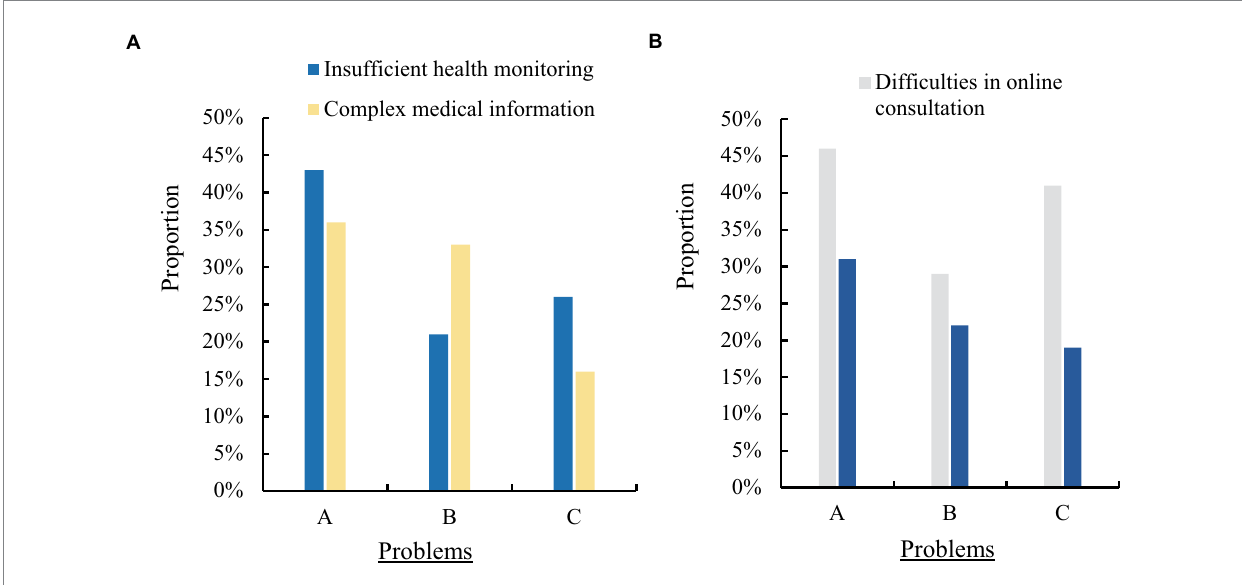
FIGURE 5 Deficiencies of community health archives management system in the current public health information construction. (A) Insufficient health monitoring and complex medical information. (B) Difficulties in online consultation and insufficient information